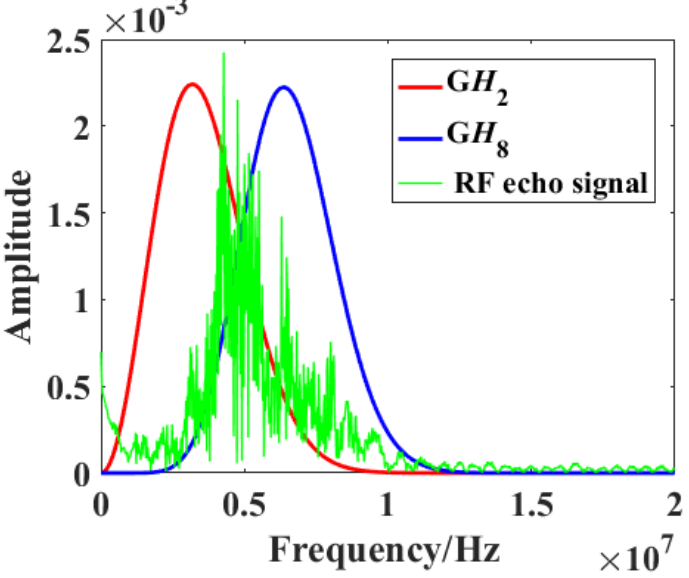
Figure 2. Frequency spectra of the raw radiofrequency (RF) signal (green) and the G H 2 (red) and G H 8 (blue) filters.